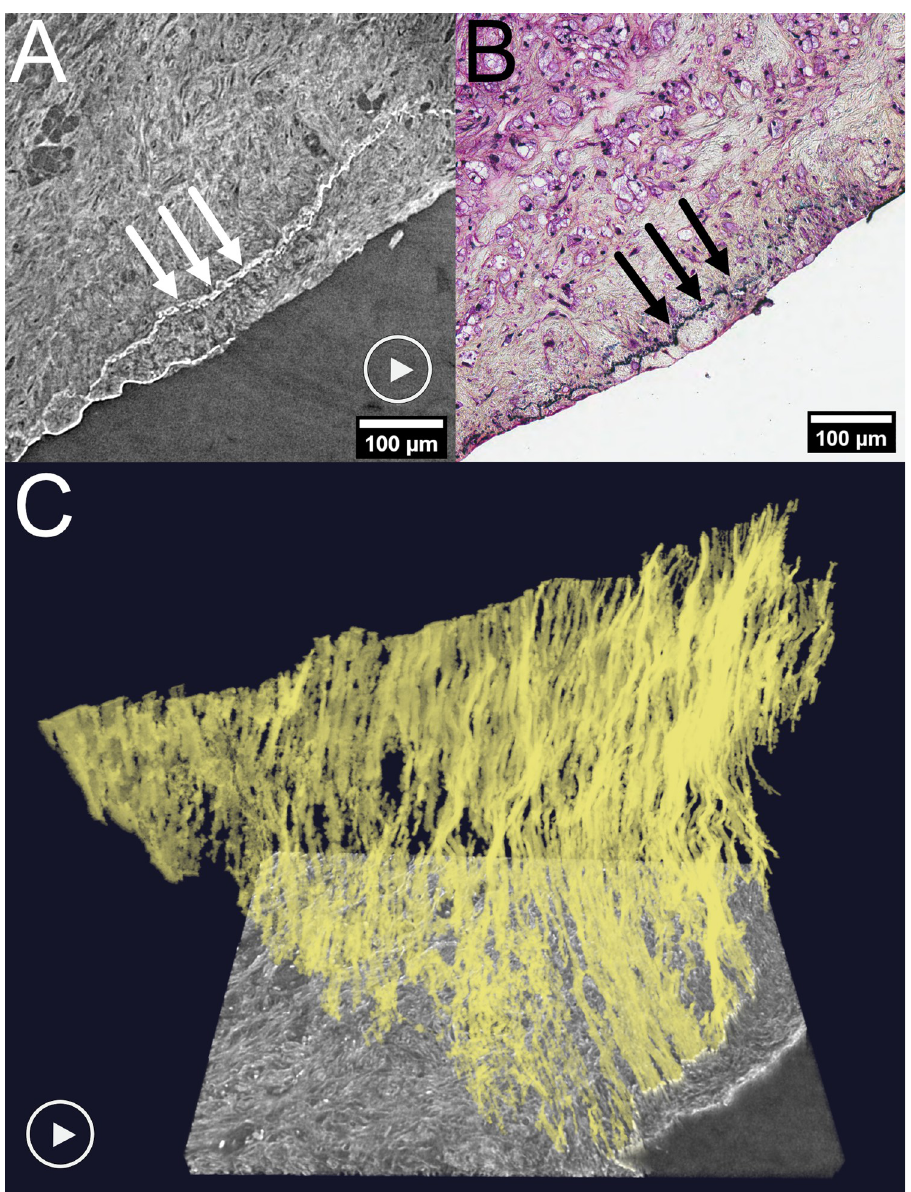
Fig 8. Internal elastic membrane depicted in 2D image stacks, histology and 3D rendering. HR SR μ CT (A) and a histologic section with Movat staining (elastin in black) (B) . The arrows indicate the internal elastic membrane (white arrows in A and black arrows in B). (C) 3D reconstruction. "Play" symbols in (A) and (C) indicate movie material showing the membrane’s multiplanar course in the tomographic display (S11 Movie in S1 File) and the 3D rendering (S12 Movie in S1 File). Plaque ID 5 in S1 Table in S1